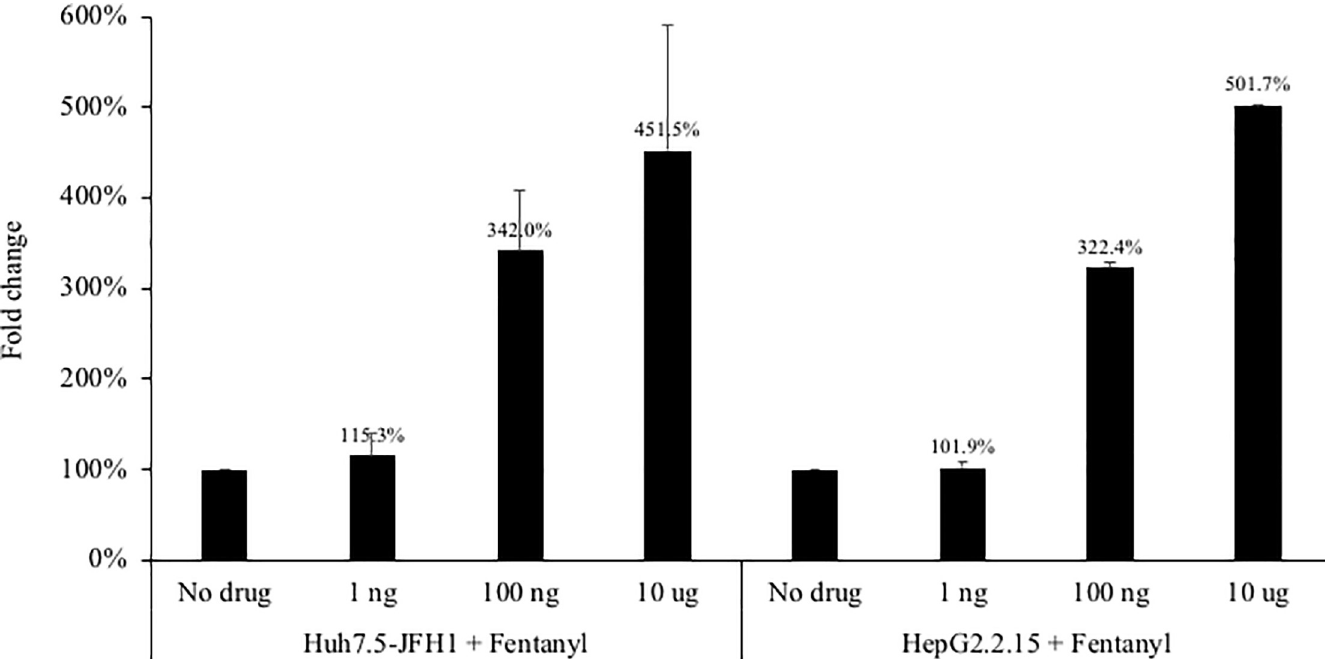
Fig 6. The Huh7.5 JFH1 or HepG2.2.15 hepatocyte cell lines were seeded at 500,000 cells per well. Fentanyl was added to culture medium after 24 hours. After 3 days of incubation with drug, M30 (units/mL) was quantified in culture supernatants. ANOVA for dose effect: p = 0.0018 for Huh7.5 JFH1 and p = 0.0003 for